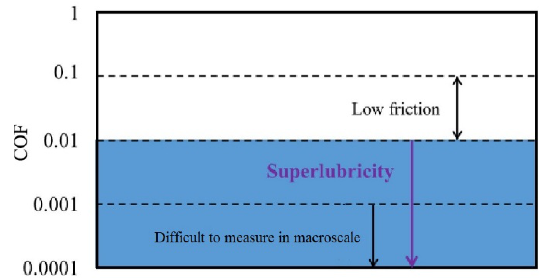
Fig. 1 COF range in superlubricity region.